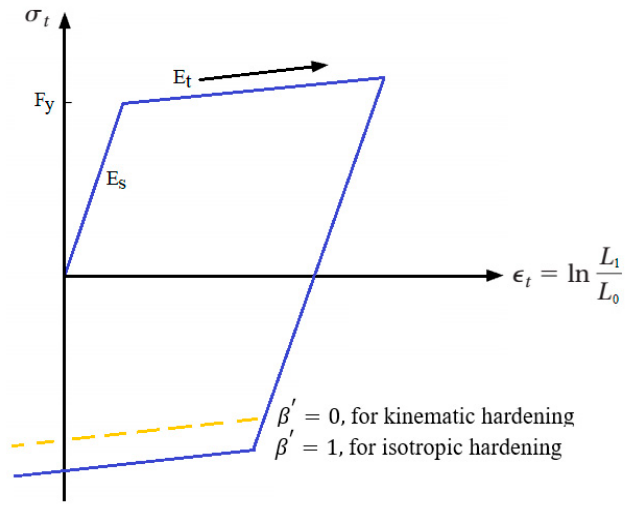
Figure 1. Stress–strain curve of MAT_PLASTIC_KINEMATIC model used for steel material [58] .